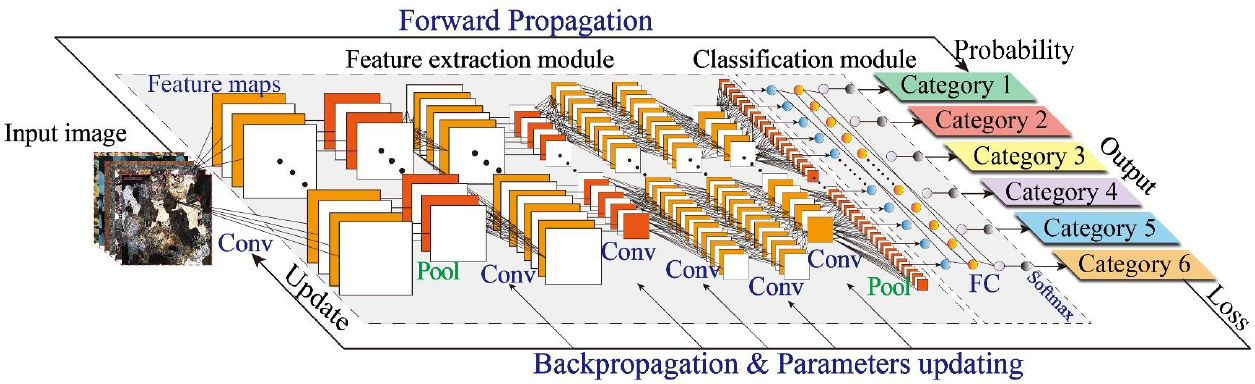
Figure 3. The structure and workflow of CNN model.